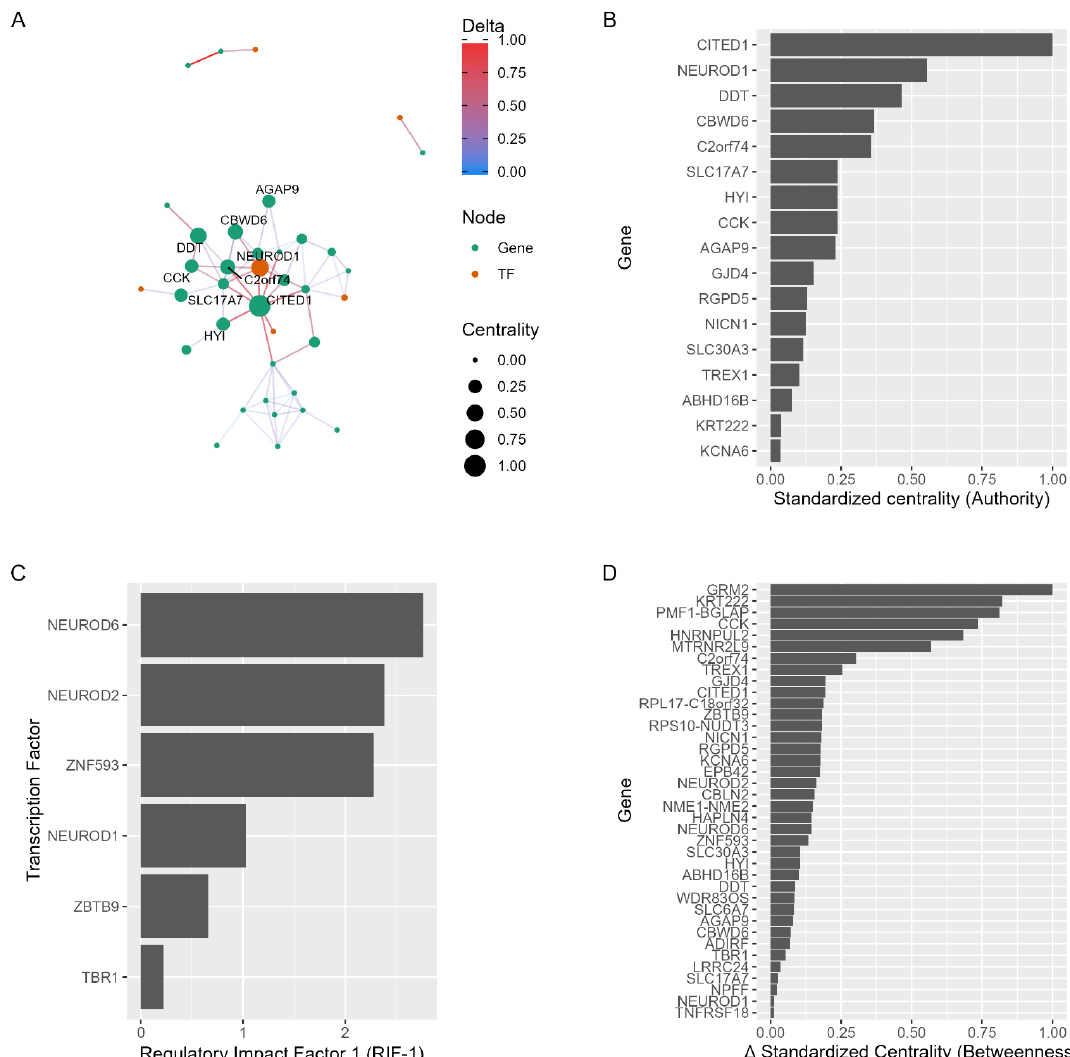
Figure 3. Differential network and measures of network regulators. ( A ) Differential network for PDC1 and PDC2 DEGs networks. ( B ) Bar plot for standardized centrality of genes from the differential network. ( C ) RIF 1 scores of genes from the differential network. ( D ) Difference in standardized centrality between genes from PDC1 and PDC2 networks (shown in Figure 2B,C).